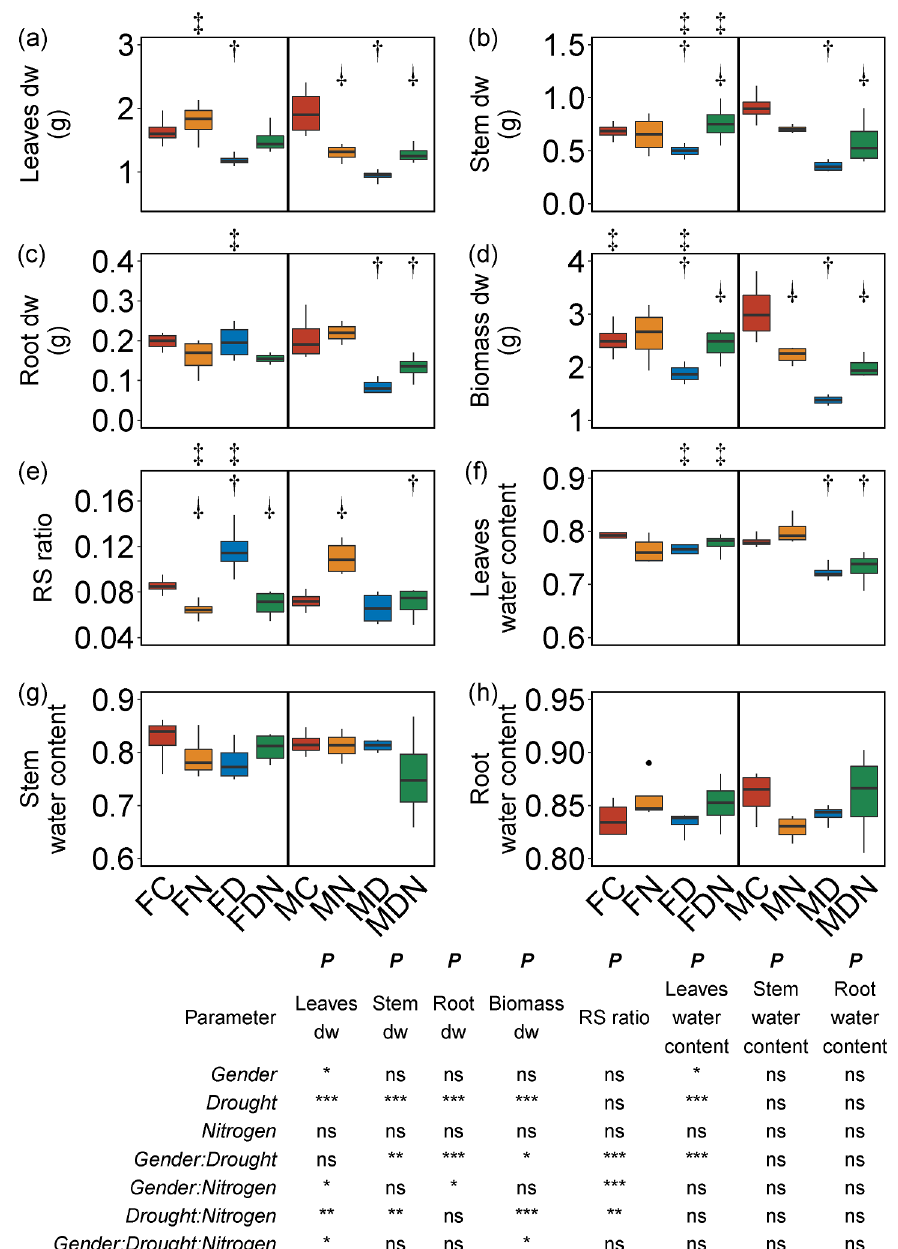
Figure 2. The biomass accumulation and water status of S. myrtillacea cuttings ( n = 3). ( a ) Leaves dry weight; ( b ) stem dry weight; ( c ) root dry weight; ( d ) the total biomass of cuttings; ( e ) the RS ratio; ( f ) leaves water content; ( g ) stem water content; ( h ) root water content. F, females; M, males; C, control; N, N deposition; D, drought; DN, drought and N deposition. The double dagger (‡) indicates simple effect of gender, the dagger (†) indicates simple effect of drought, and the inverted dagger ( ⸸ ) indicates simple effect of N deposition. The black dot indicates outlier. Asterisks denote significant differences: ***, p < 0.001; **, p < 0.01; *, p < 0.05.